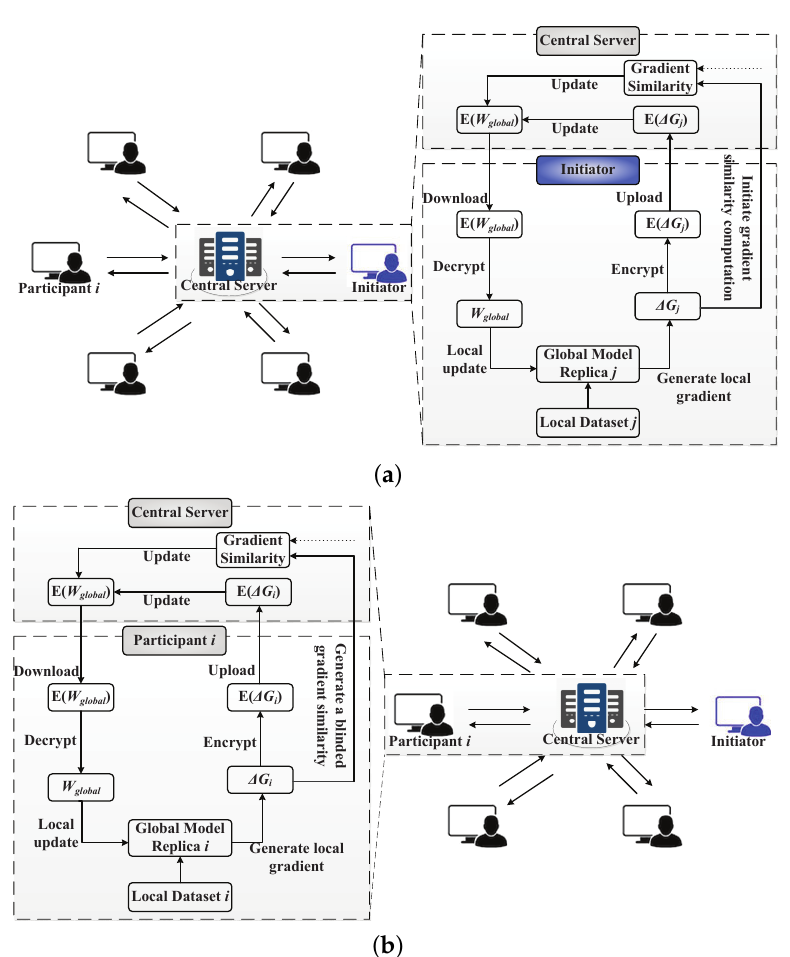
Figure 1. An architecture of our proposed multi-party privacy-preserving logistic regression with poor quality data filtering. ( a ) The learning process of the initiator. ( b ) The learning process of a participant i